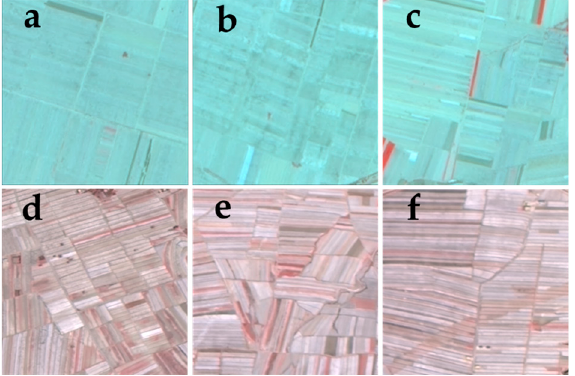
Figure 2. The PMF representative subset imagery (R = NIR, G = Red, B = Green) for determining the appropriate spatial resolution ( a – c are the representative subsets in Jizhou; and d – f are the representative subsets in Guyuan).